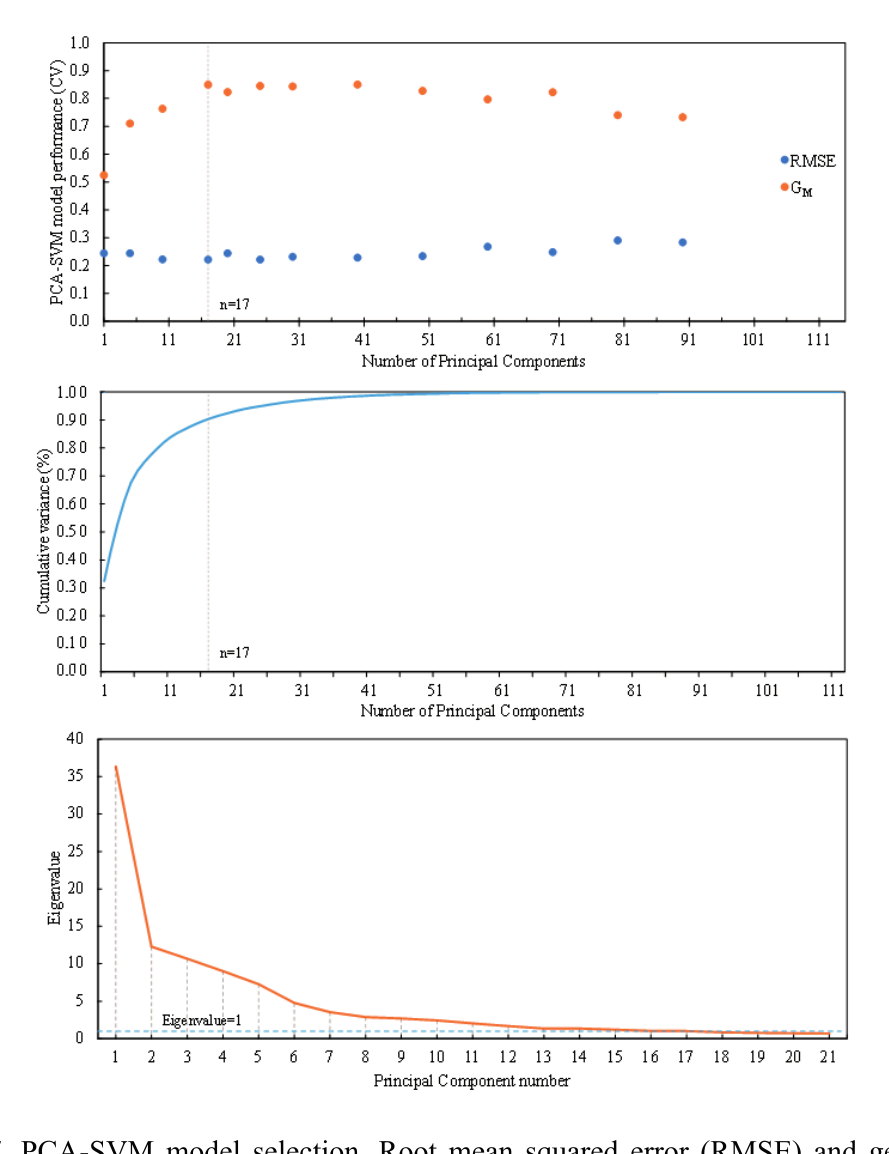
Figure 7. PCA-SVM model selection. Root mean squared error (RMSE) and geometric mean of sensitivity and specificity (G M ) as a function of the number of principal components ( Top ). Cumulative proportion of variance explained versus factors ( Middle ). Cattell scree plot with factors on the x-axis and eigenvalues on the y-axis ( Bottom